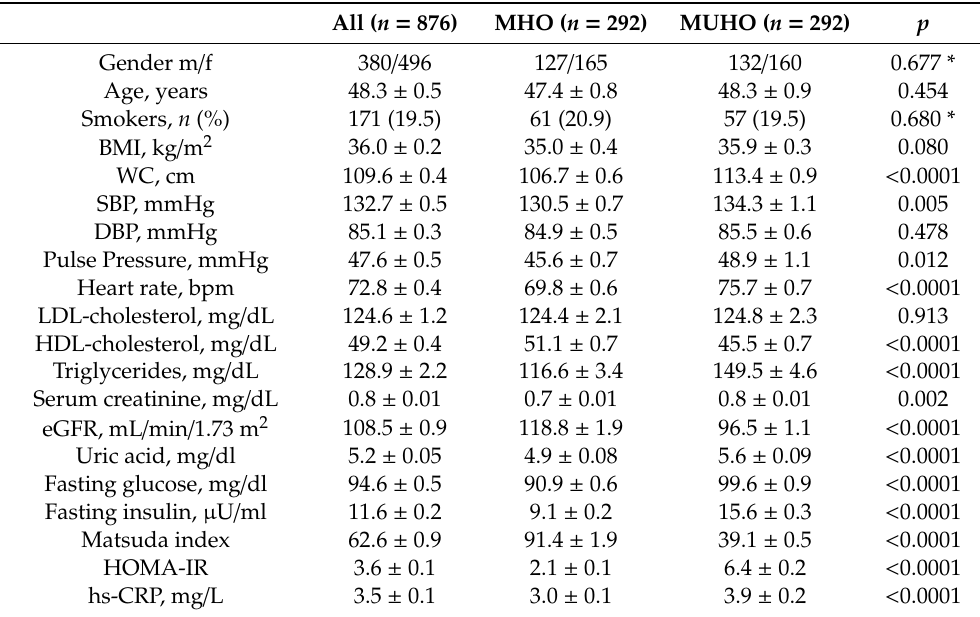
Table 1. Anthropometric, hemodynamic and biochemical characteristics of the whole study population and according to di ff erent obesity